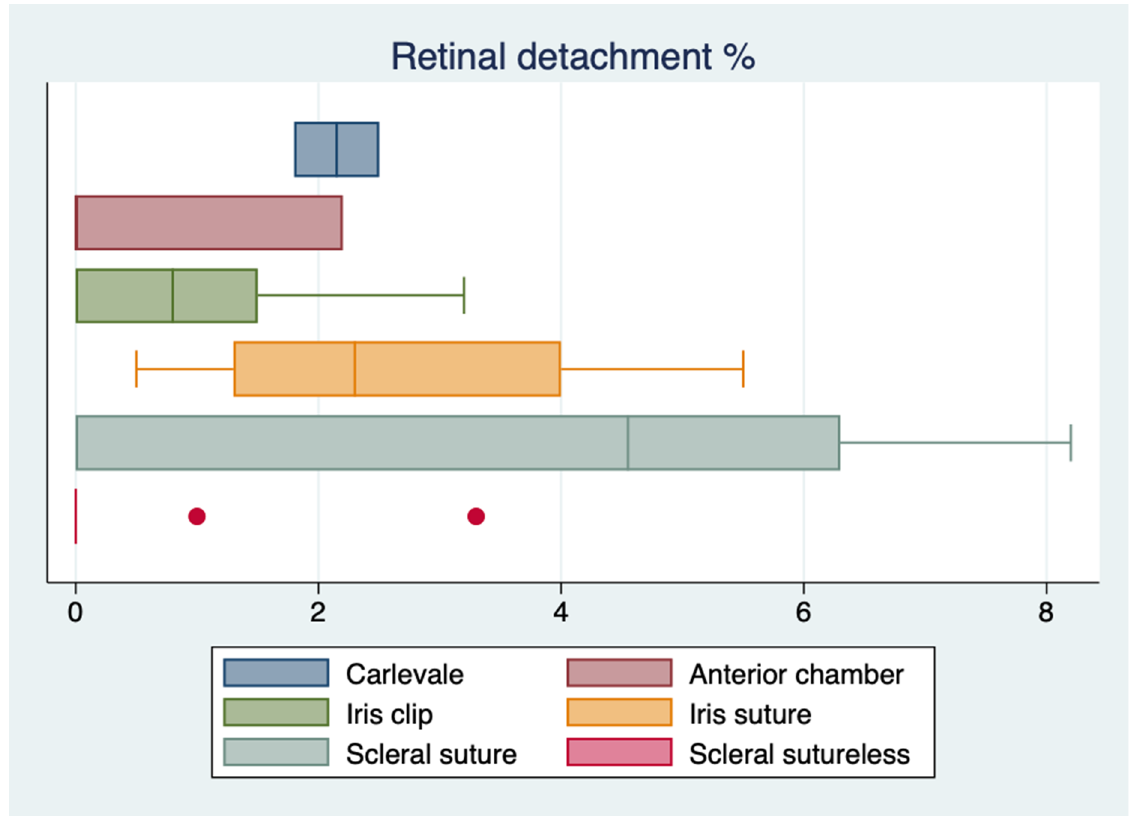
Figure 4. Boxplot of retinal detachment reported incidences.